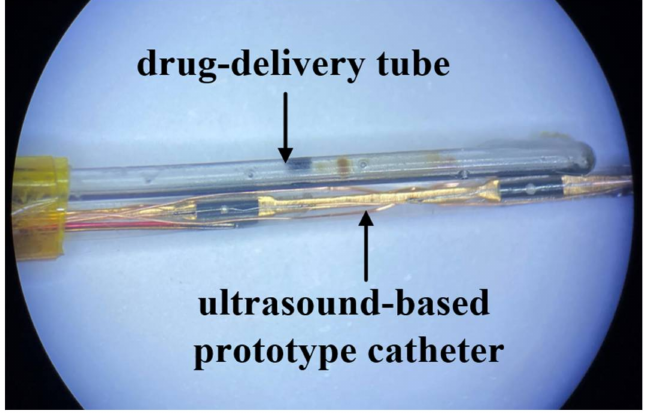
Figure 3. Thrombolysis catheter